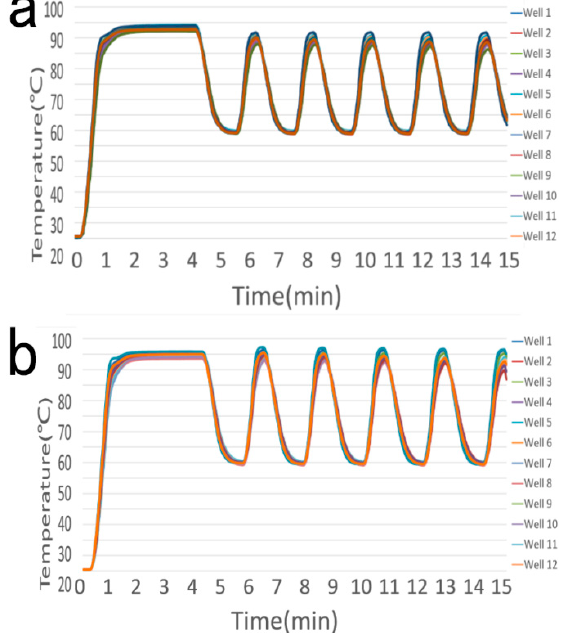
Figure 3. Temperature Curve of the Homemade PCR Amplification Program. ( a ) Before the upgrade (the pre-denaturation step at 95 °C for 3 min, the denaturation step at 95 °C for 15 s, and the anneal- ing/extension step at 60 °C for 35 s); ( b ) After the upgrade (the pre-denaturation step at 97.2 °C for 3 min, the denaturation step at 100.4 °C for 15 s, and the annealing/extension step at 60.6 °C for 35 s).